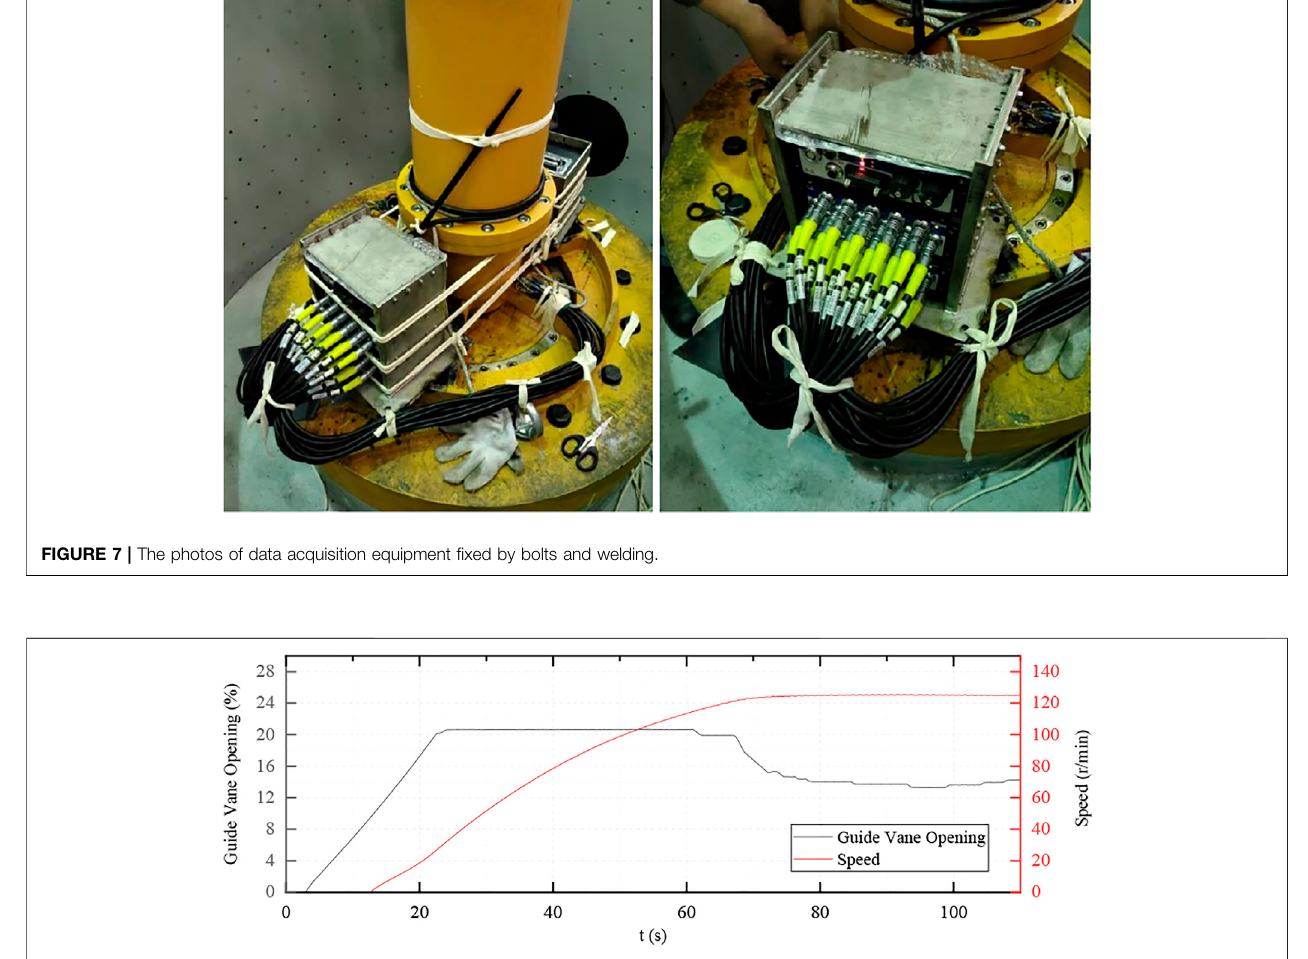
FIGURE 8 | The curve of the guide vane opening and the speed (single-stage acceleration).